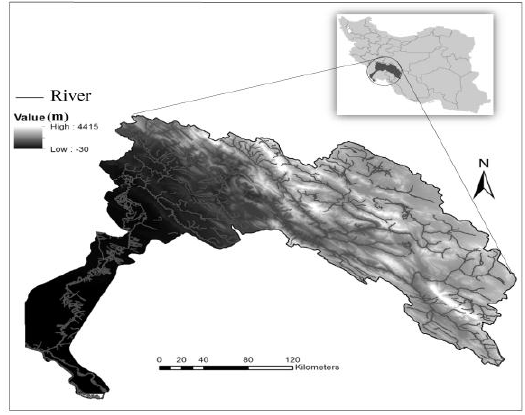
Figure 1. Map of Karoun